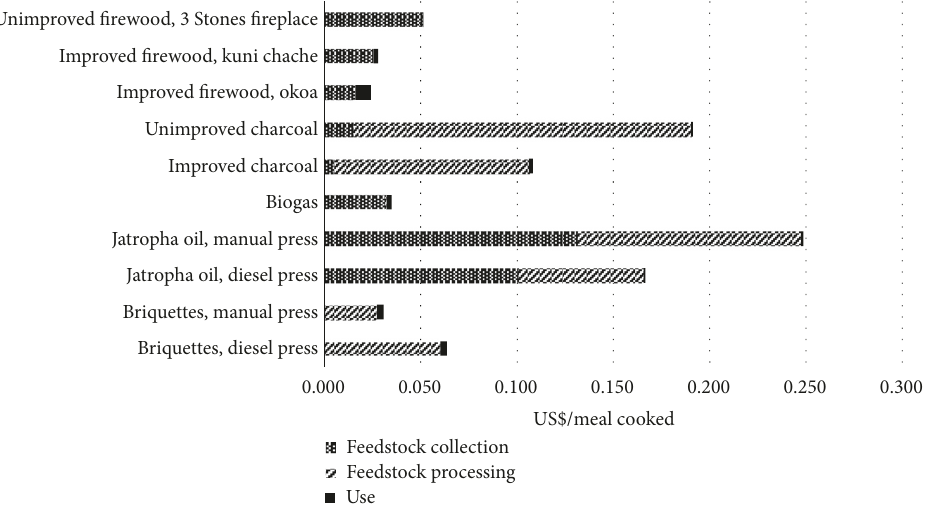
Figure 2: Life cycle costs per meal cooked (US$) incurred over the different energy value chains in rural Moshi, Tanzania.